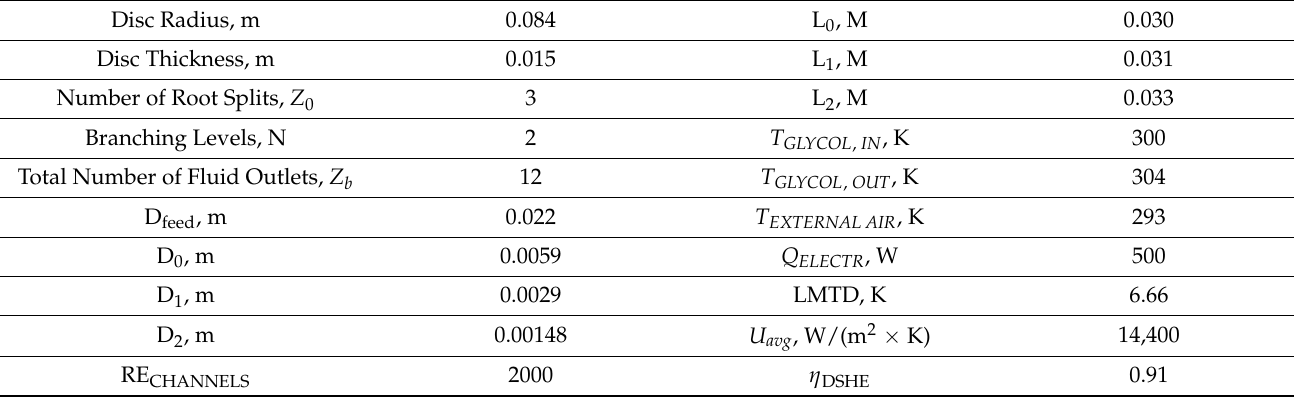
Table 3. Improved design of the DSHE of example 5.1.